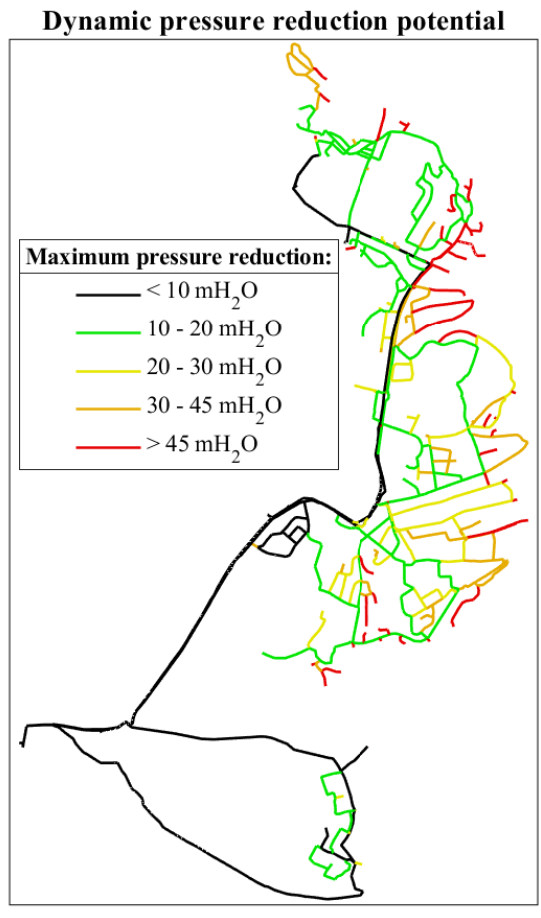
Figure 2. Maximal dynamic pressure reduction potential for a portion of Trondheim’s WDN, from